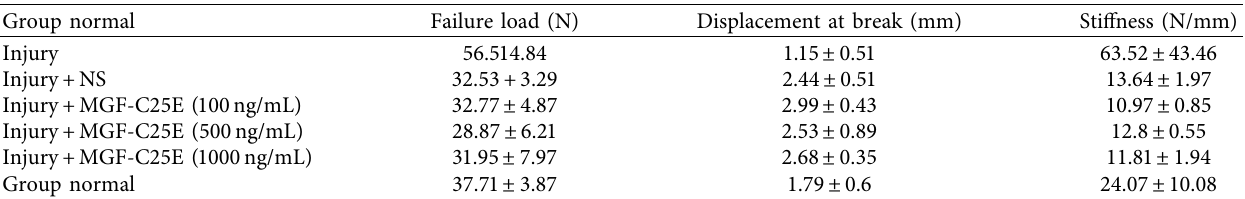
Figure 9: Effect of MGF-C25E on AFI of injured Achilles tendon. Table 4: Mechanical measurement results.